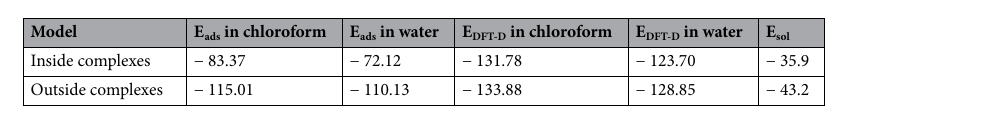
Table 1. The adsorption energies (E ads ) at the M06-2 × and M06-2x-D3 levels in chloroform and water solvents, the solvent energies (E sol ) of the drug delivery systems. Unites of energies are in kJ/